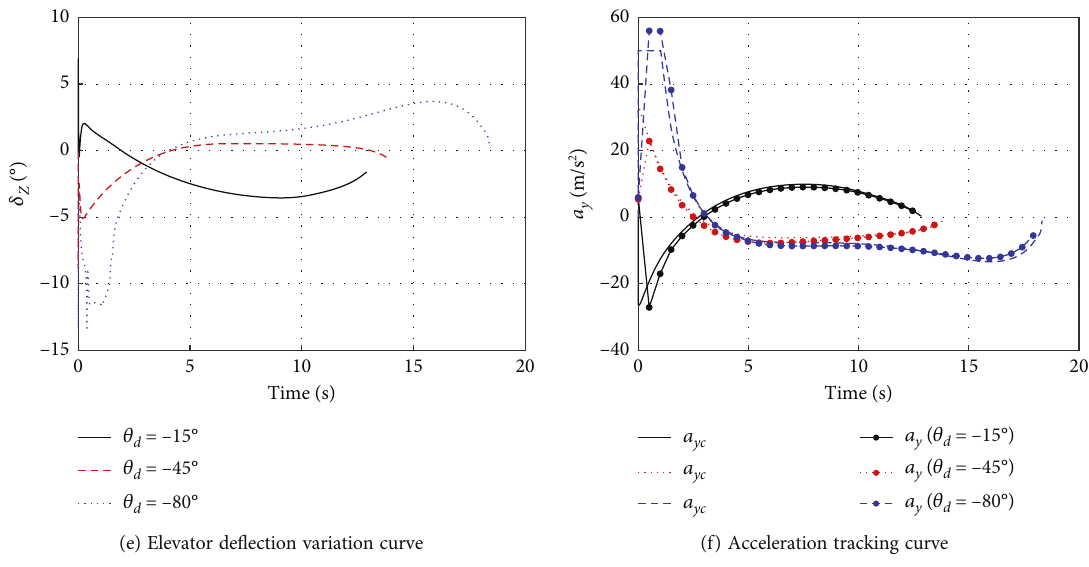
Figure 11: Control ballistic simulation